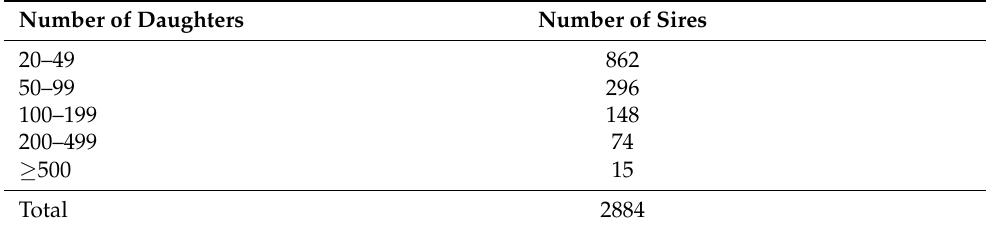
Table 1. Distribution of size of progeny groups in the file restricted to 10 daughters per